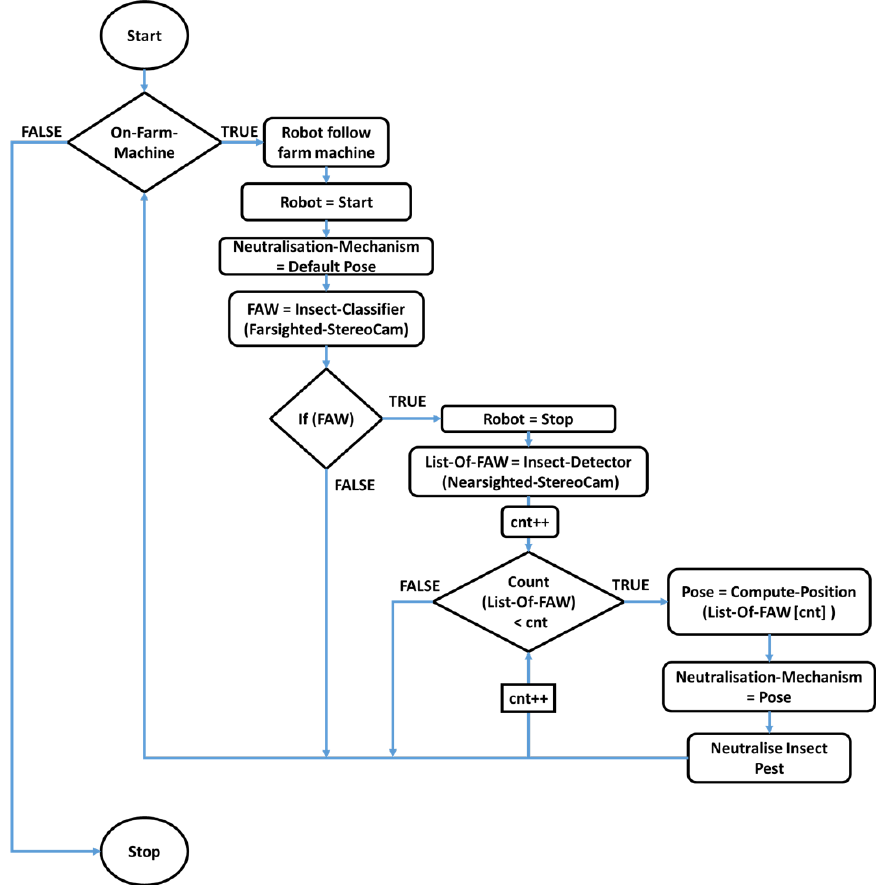
Figure 4. Proposed deep learning-based robot-centered insect pest larvae recognition